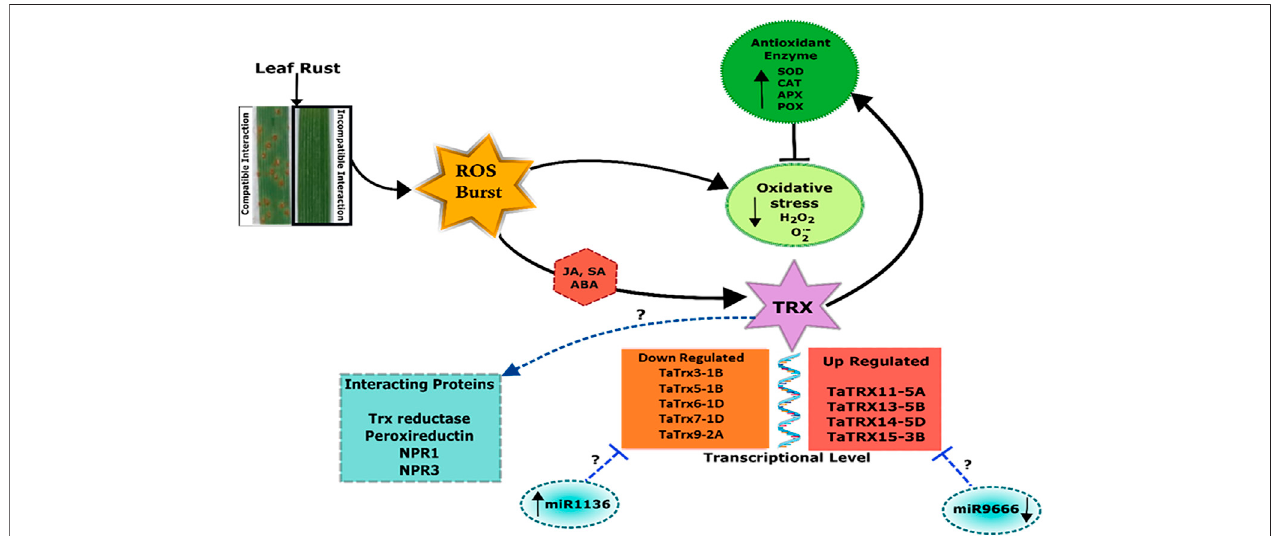
FIGURE 10 | Schematic model showing thioredoxin (Trx)-mediated regulation of incompatible interaction between wheat and leaf rust pathogen. Figure is made based on the results and in silico prediction (enclosed in dashed lines).